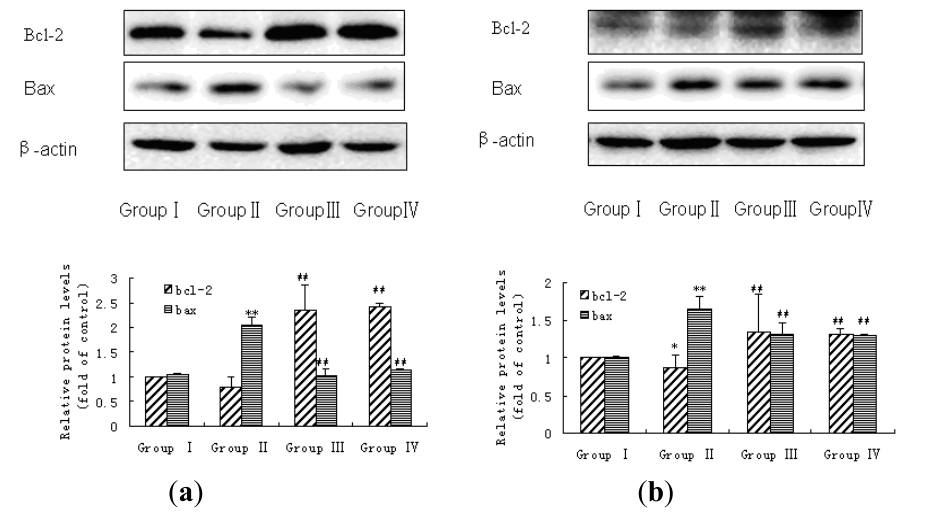
Figure 3. The expressions of Bcl-2 and Bax in liver and kidney of rats. ( a ) Liver was isolated for western blot analysis to determine protein expressions of Bcl-2 and Bax. ( b ) The expressions of Bcl-2 and Bax in kidney were